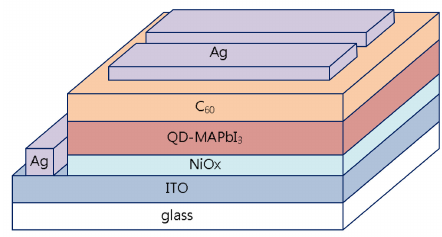
Figure 9. Structural diagram of the QD-MAPbBr 3 solar cell.